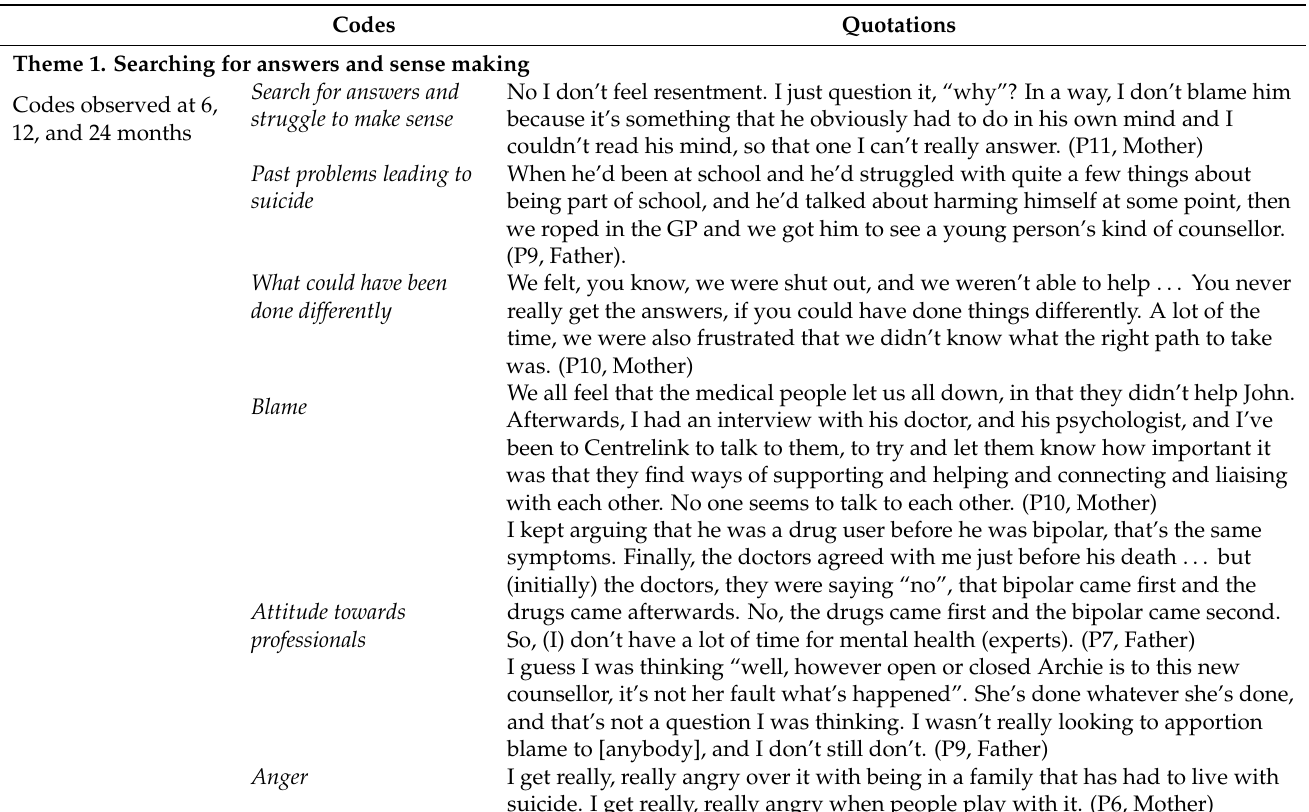
Table 1. Themes and codes at different waves of the study (Please note that pseudonyms have been used instead of real names). Codes Quotations Theme 1. Searching for answers and sense making Codes observed at 6, 12, and 24